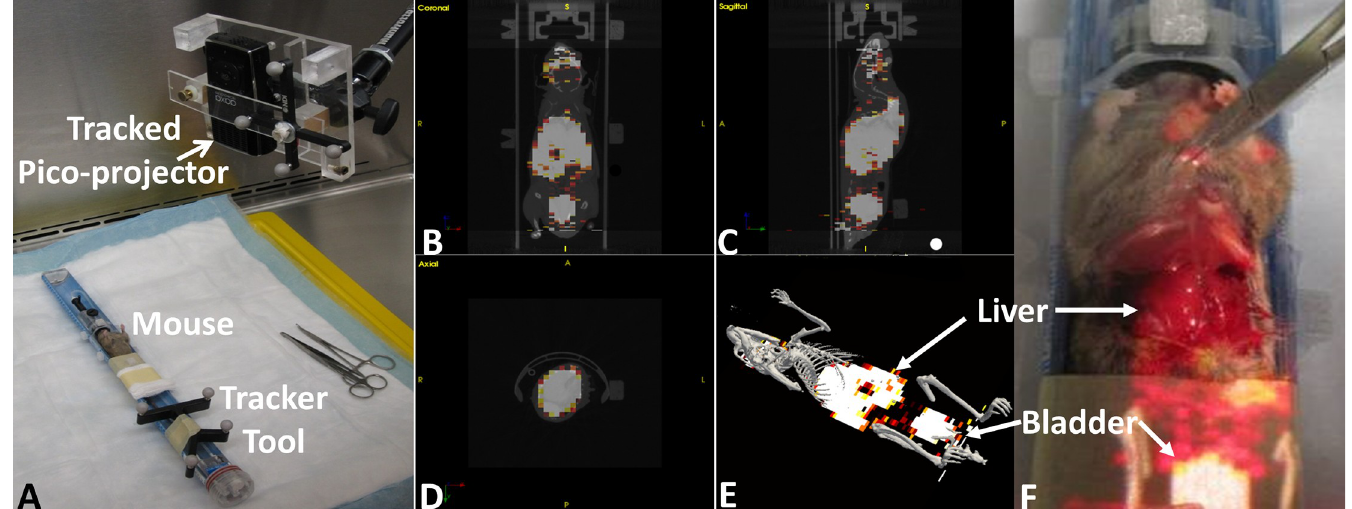
Fig 2. Augmented reality guided procedure with immunocompetent CD-1 healthy mouse model using PET/CT image. (A) experimental setup (B), (C) and (D) tri- planer view of coronal, sagittal and axial imaging slices respectively. d) virtual image containing 3D skeleton (gray) and coronal slice of PET image. (F) showing the image projection on the abdominal surface of dissected mouse indicate the accumulated isotope in the liver and bladder.